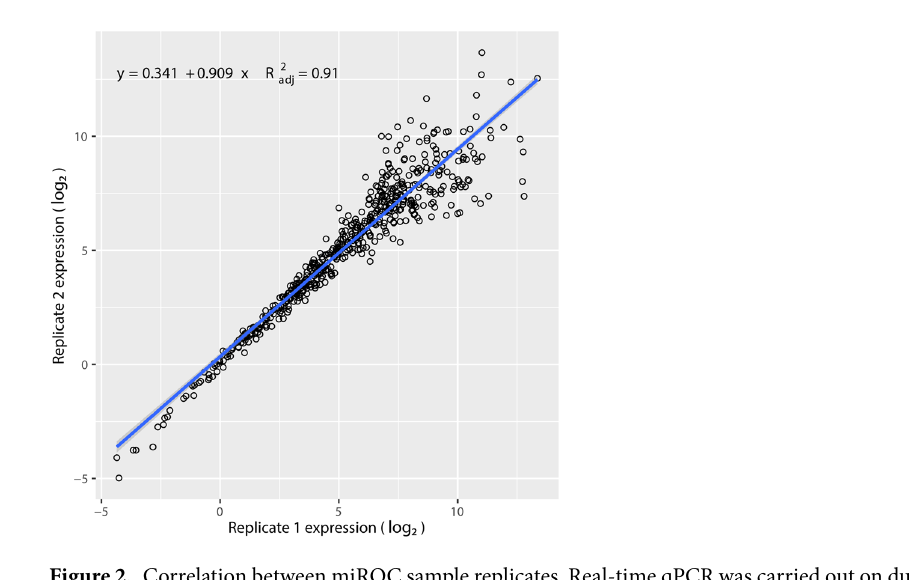
Figure 2. Correlation between miRQC sample replicates. Real-time qPCR was carried out on duplicate miRQC samples to evaluate the reproducibility between miRSCan ™ PanCancer chips. Correlation analysis was performed using the resulting two qPCR datasets of duplicate samples (samples 1, 3, 5, 7 for replicate 1 and samples 2, 4, 6, 8 for replicate 2). Filled circles represented data from replicate 1, and open circles represented data from replicate 2. Correlation of 0.91 indicates that miRSCan ™ PanCancer chips have high is also suitable for identifying individuals who are healthy because of its high specificity. For the purpose of this study, the diagnostic performance of OSCC classifier did not take into account factors such as clinicopathological state of the tumor and the patients’ age, sex, ethnicity or betel nut chewing/smoking habits. The classifier is composed of 134 miRNAs. We next determined the average number of miRNAs, out of the 134, that were detected in the plasma of healthy subjects and patients with OSCC. Using only 0.2 ng total miRNA as starting concentration, 93 and 97 miRNAs were detected on average in healthy subjects and patients, respectively (Table 4). The level of miRNAs in plasma is often lower compared to those in tissue samples, but PanelChip ™ was capable of detecting a high number of plasma miRNAs, suggesting that the system is well-suited for the detection of circulating miRNAs.